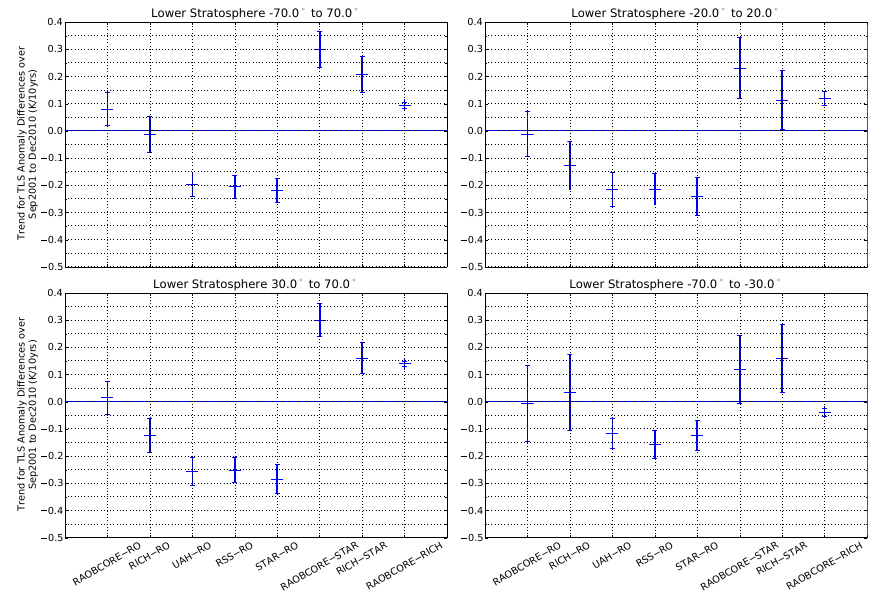
Fig. 11. Trend values of anomaly differences with 95% confidence interval for quasi-global, tropics, and NH/SH extratropics regions (top left to bottom